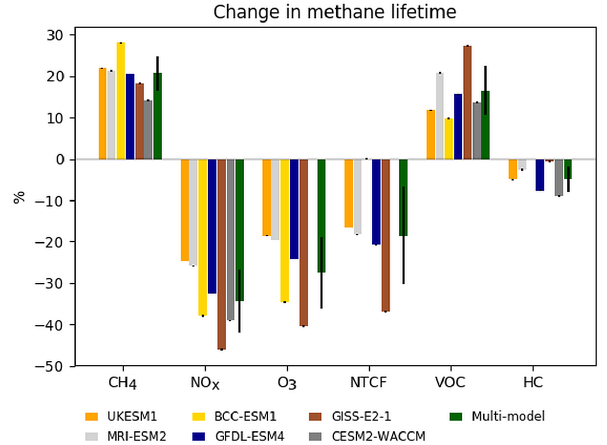
Figure 10. SARF for WMGHGs, ozone and diagnosed changes in methane. Model-diagnosed direct aerosol RF and cloud radiative effect. Crosses mark the sum of the five terms for each model. Stars mark the diagnosed ERF with the effect of methane life- time (on methane and ozone) added. Differences between stars and crosses show undiagnosed contributions. Uncertainties on the sum are mainly due to the uncertainties in the radiative efficiencies. Un- certainties in the ERF are errors on the mean due to interannual vari- ability. Note that for CESM2-WACCM, BCC-ESM1 and GISSE21 the direct aerosol effect is